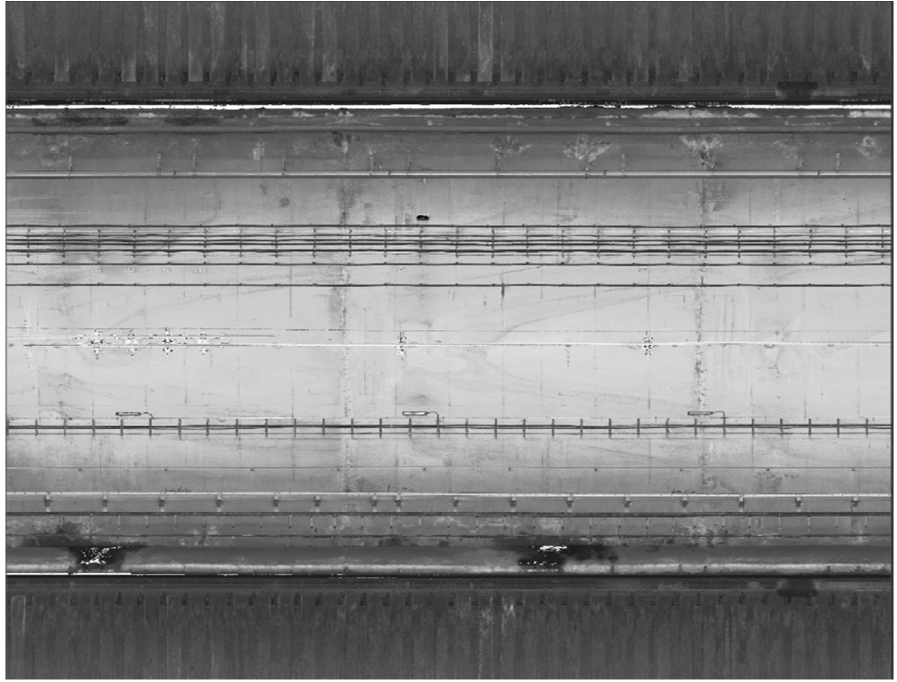
Figure 7. Preview image of tunnel